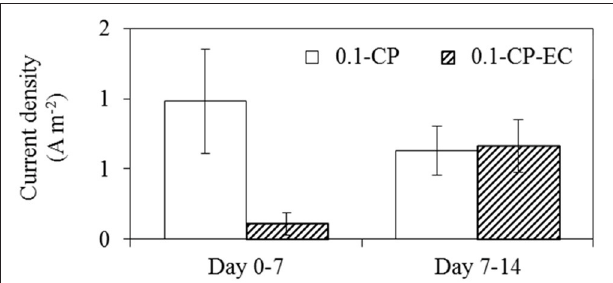
FIGURE 7 | Mean current density of 0.1 µ m membranes experiments; control experiment (0.1-CP) and electrochemical cleaning experiment (0.1-CP-EC) during day 0–7 and day 7–14, the error bars show the standard deviation of current